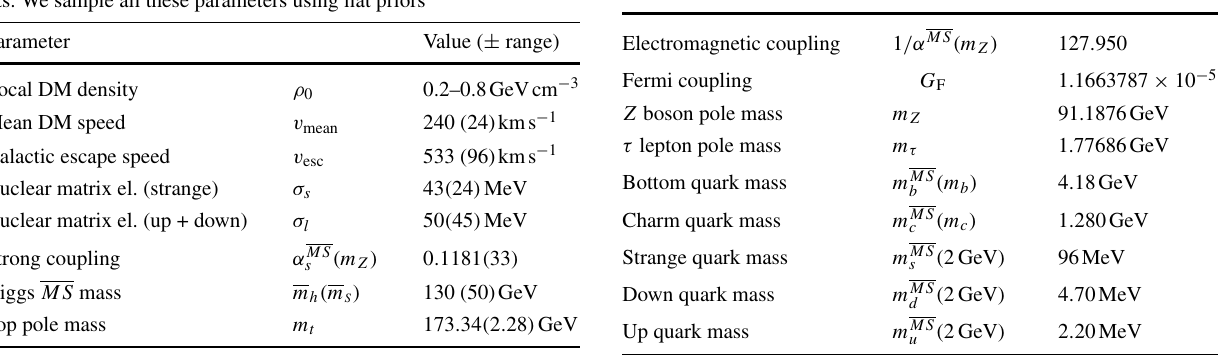
Table 3 Names and values of parameters that we hold fixed in our fits Parameter Fixed